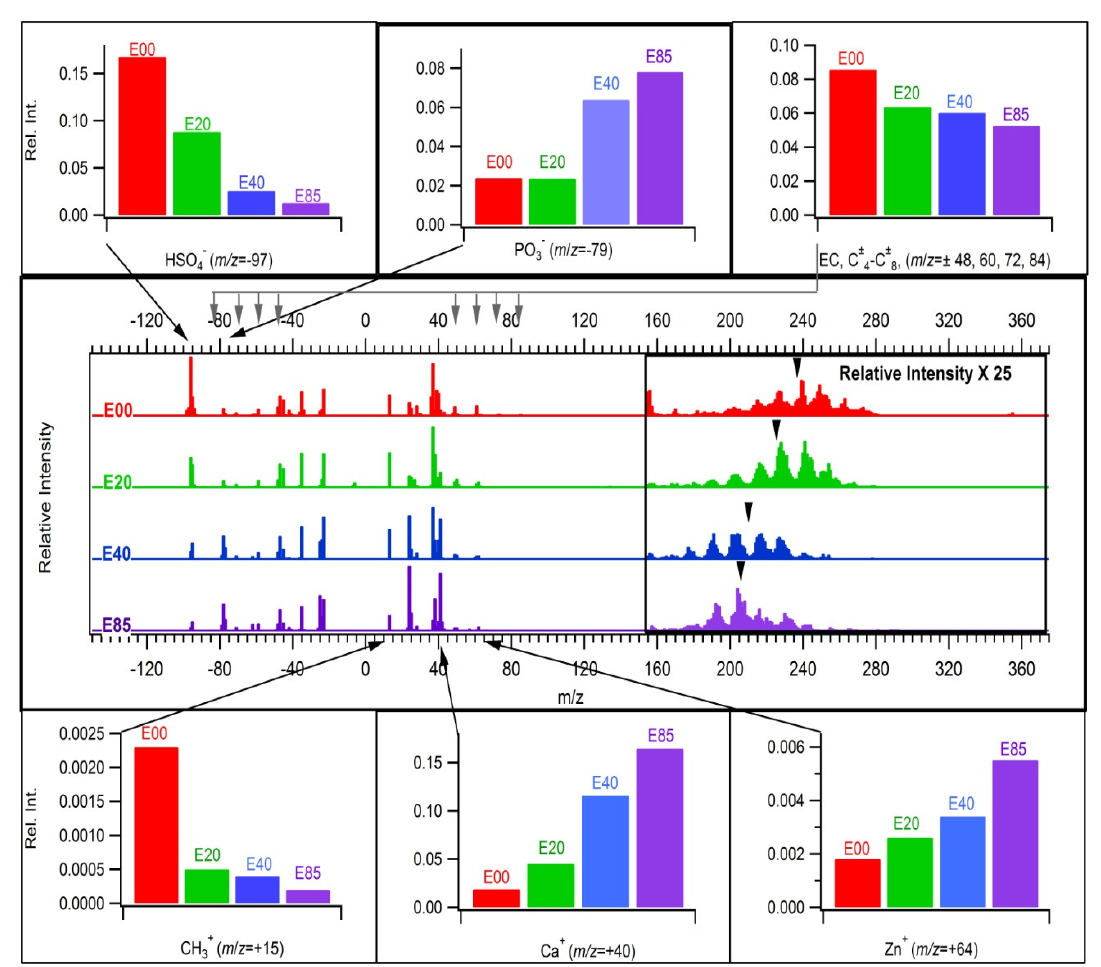
Figure 3. Average single-particle mass spectra for each fuel type. The PAH region is magnified. The arrows in the magnified PAH region show the arithmetic average molecular weight of observed PAHs. Trends in the relative peak areas of certain key species as a function of fuel ethanol content are shown in bar graphs, and labeled by fuel